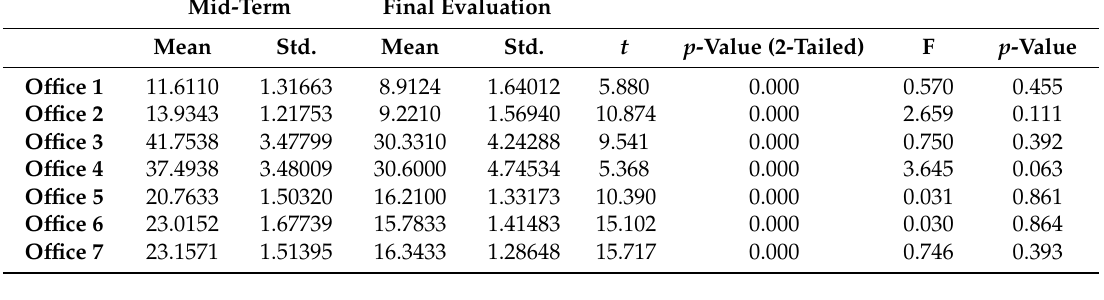
Table 7. Results of the Student’s t -test and Levene’s test performed to assess the difference of means and variances between the Mid-term period data (Intervention period) and the Final evaluation eriod data (Intervention period) data collected during the experimentation. All the offices present a lower percentage of energy usage after the experimentation.